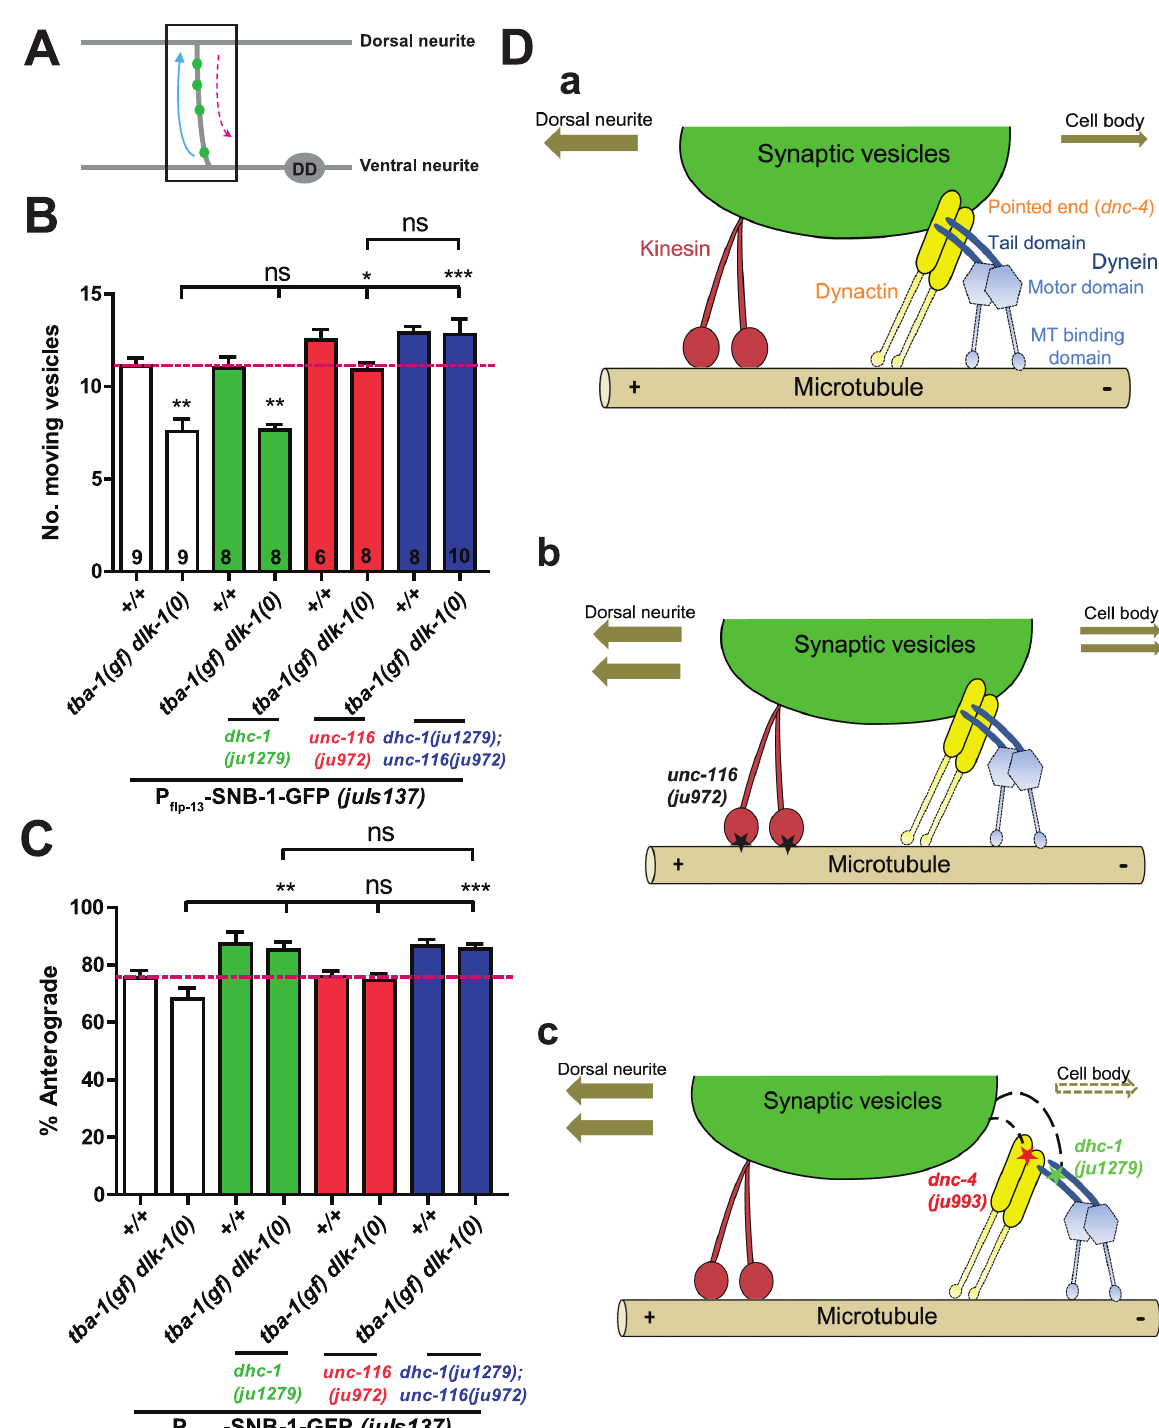
Fig 3. dhc-1(ju1279) enhances anterograde transport during synapse remodeling. (A) Schematicof imagingregion(black box) in the DD neuron. SVs move in both the anterograde (blue solid arrow) and retrogradedirections (pink dotted arrow) during remodeling.(B, C) Quantification of: (B) number of mobilevesicles, (C) their direction of movementduring remodeling for various genotypes.Data are mean ± SEM; n = no. of animals(shown on (B)). Statistics: One-way ANOVA followedby Tukey’s posttest; * p < 0.05, *** p < 0.001, ** p < 0.01,n.s.-not significant(D Model of bidirectionalcargo transport duringDD neuronsynapse remodeling. a) In wild type animals, kinesin(red) and the dynein (blue)-dynactin (yellow) complextransport SVs in both the anterograde